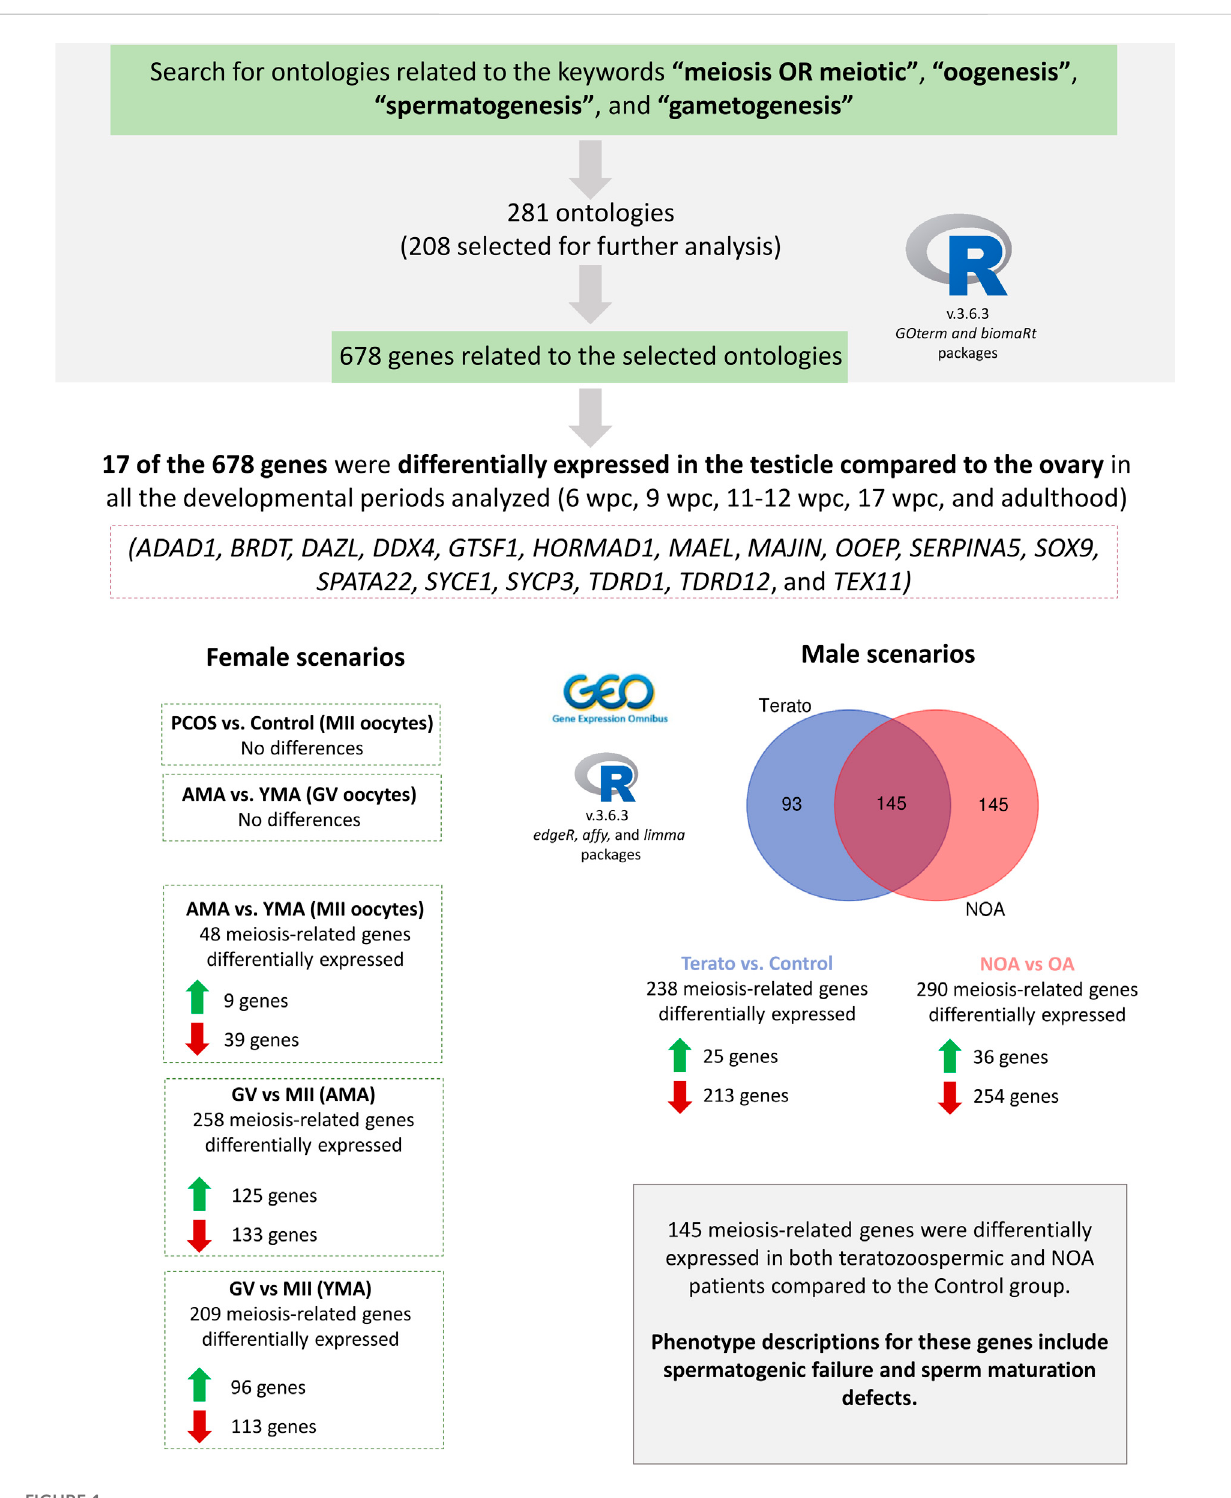
FIGURE 1 Studydesignandmainresultsfound.Asearchforgeneontology(GO)termsrelatedtothemeiosisprocesswasconductedintheRsoftware,resultingin281GO terms. Of these, 208 were selected, being further associated with 678 meiosis-related genes. Six datasets were selected in the Gene Expression Omnibus (GEO)